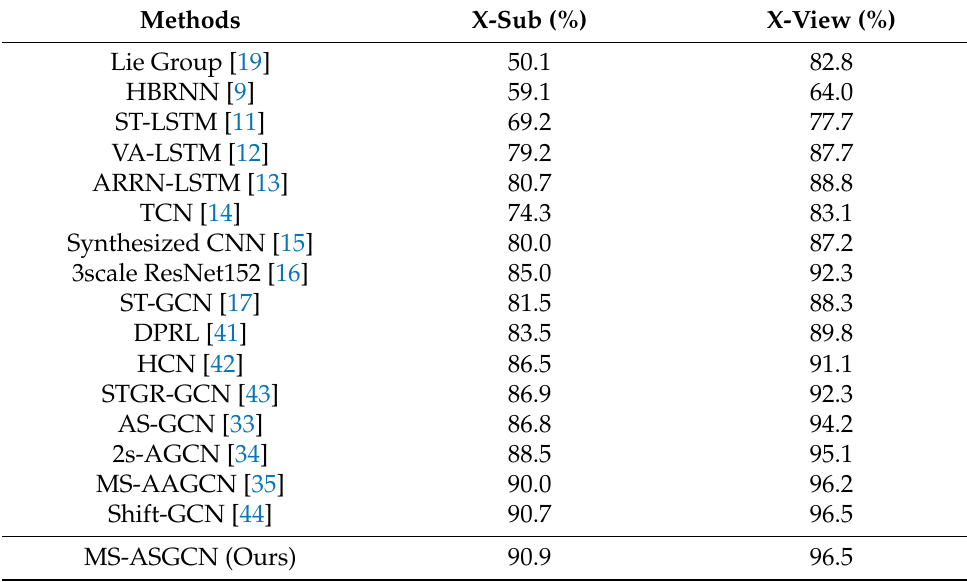
Table 7. Comparison of action recognition accuracy with state-of-the-art methods on the NTU-RGB+D dataset. Top-1 accuracy is reported in both settings.